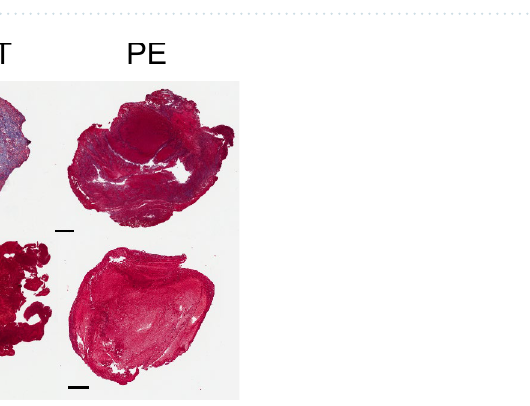
Figure 1. The fractional area of collagen, fibrin, platelets, and erythrocytes (RBC) present in (top) all analyzed VTE specimen (26 samples), (bottom left) pulmonary emboli (14 samples), and (bottom right) deep vein thrombi (12 samples). Components were assessed using histochemical staining. Colorimetric analysis was conducted in ImageScope (Leica, Biosystems, Germany) to identify pixels associated with each components. Horizontal red lines indicate median values. The top and bottom portions of the blue box represent the 25th and 75th percentiles, respectively, and whiskers extent to the data points not considered outliers. Red crosses indicate outliers, which correspond to datapoints greater than q 75 + 1.5 × (cid:31) q 75 − q 25 (cid:30) or less than q 25 − 1.5 × (cid:31) q 75 − q 25 (cid:30) , where q 25 corresponds to the 25 th percentile of the sample data, and q 75 corresponds 75th percentile of the sample data 37 .